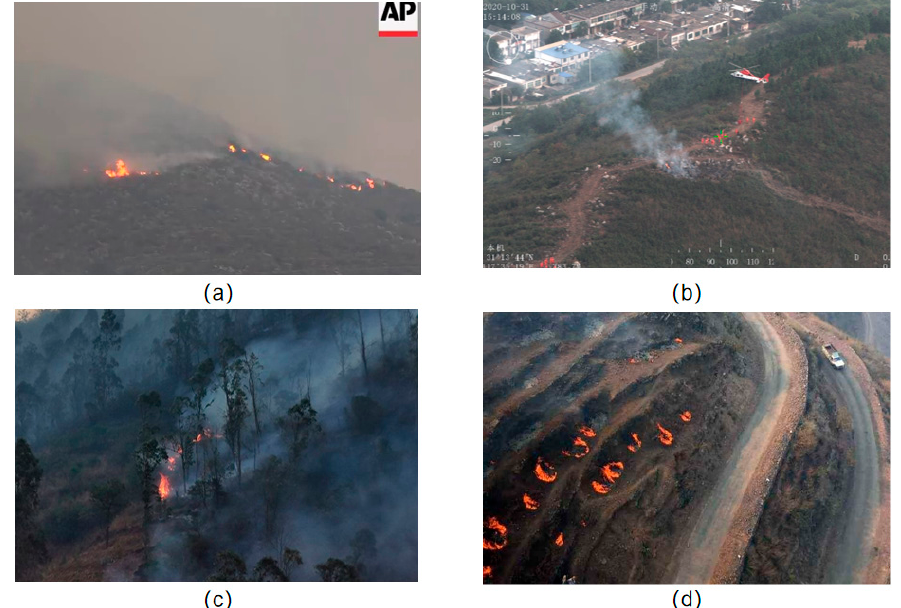
Figure 2. Representative forest fire images from the small-target forest fire dataset: ( a ) long-range photography of forest fires, ( b ) UAV overhead photography of forest fires, ( c ) initial forest fire photos, and ( d ) UAV overhead photography of forest fires.